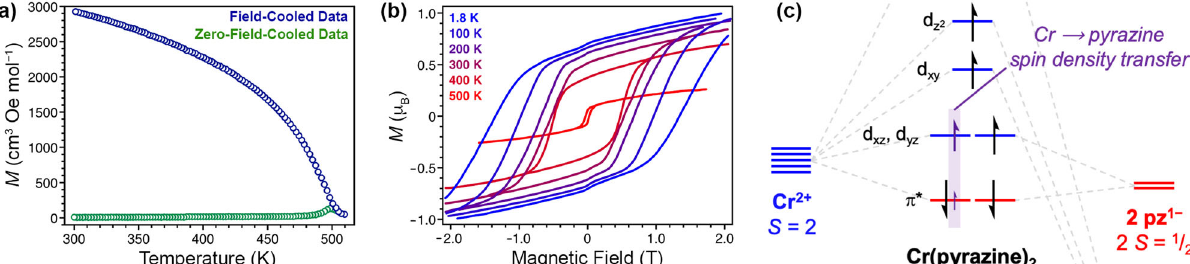
Fig. 3 High-temperature, hard magnetism in Cr(pz) 2 ·0.7LiCl. a A bifurcation in the fi eld-cooled/zero- fi eld-cooled magnetization ( M ) data below 515 K indicates magnetic order. b Magnetic hysteresis shows coercivities up to 1.35 T at 1.85 K. c Strong magnetic coupling and anisotropy arise from energy matching of molecular fragments. Figures ( a ) and ( b ) were created from the data in ref. 16